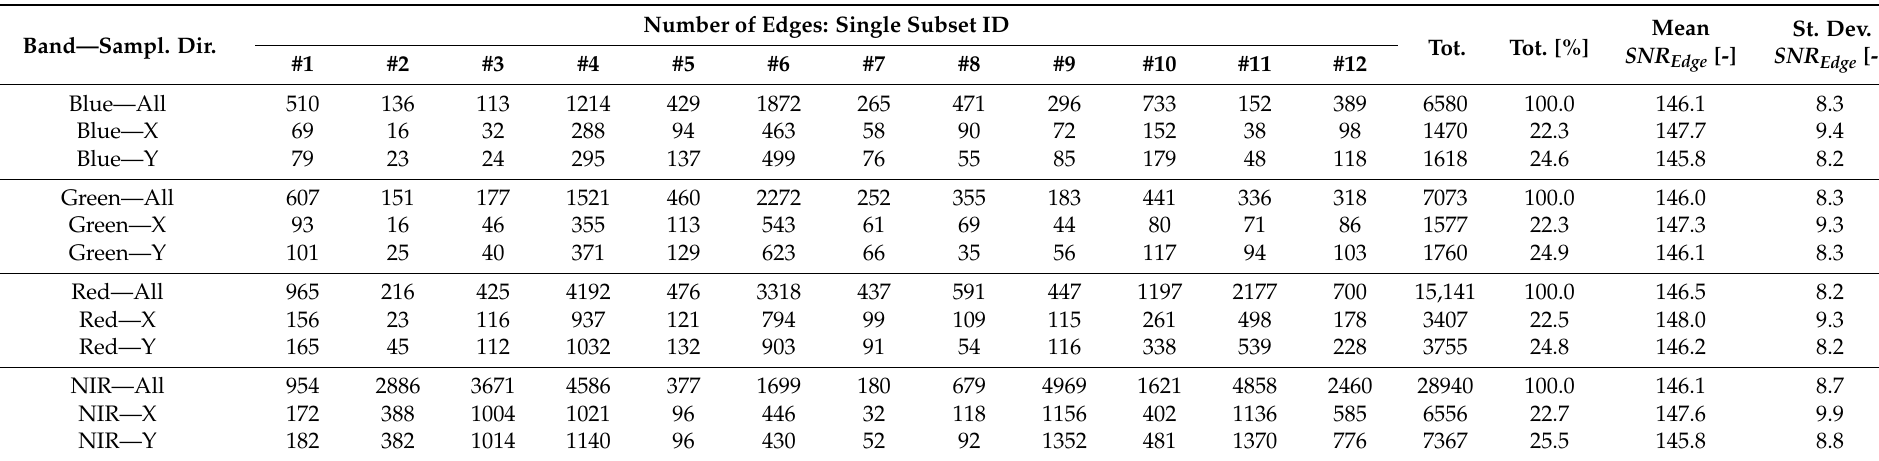
Table 3. In the table are reported the number of edges used for the SaSbEM validation for each spectral band and every category of sampling direction. In addition, also the SNR Threshold mean and standard deviation values are